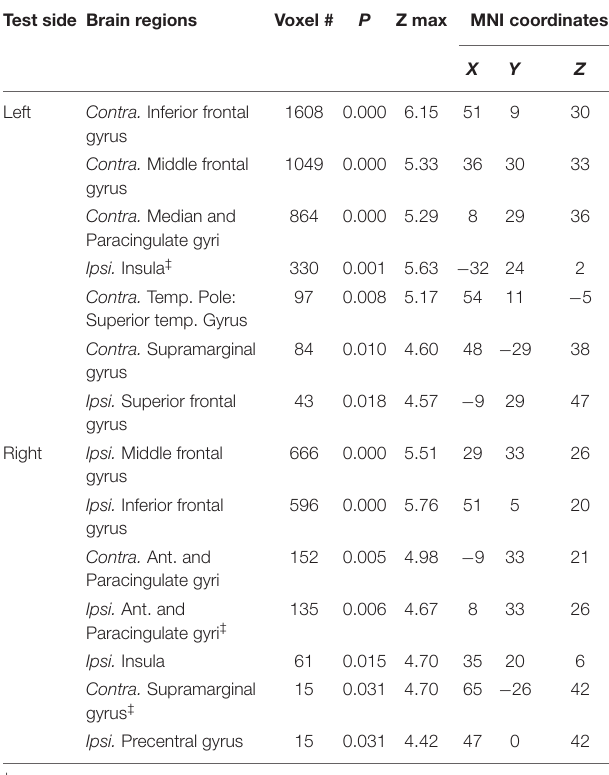
TABLE 2 | Brain regions with significantly greater bold response during JPS than Flex [( JPS > Rest )] > ( Flex > Rest )] †